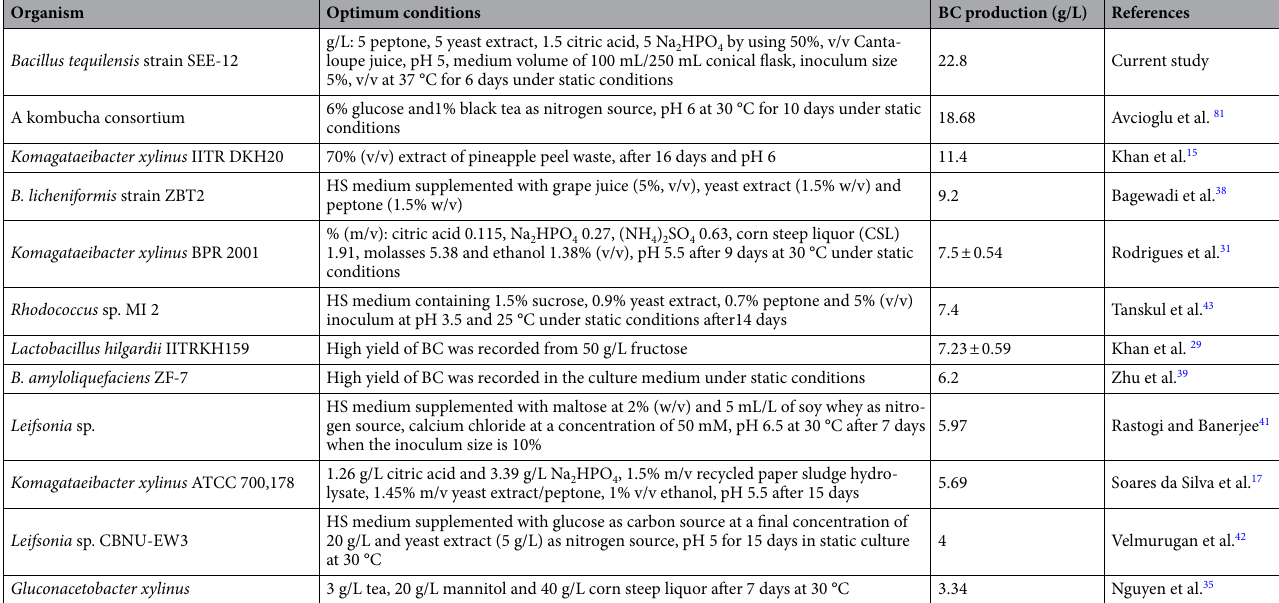
Table 3. A comparison between Bacillus tequilensis strain SEE-12 and some BC producers in terms of BC production and optimum